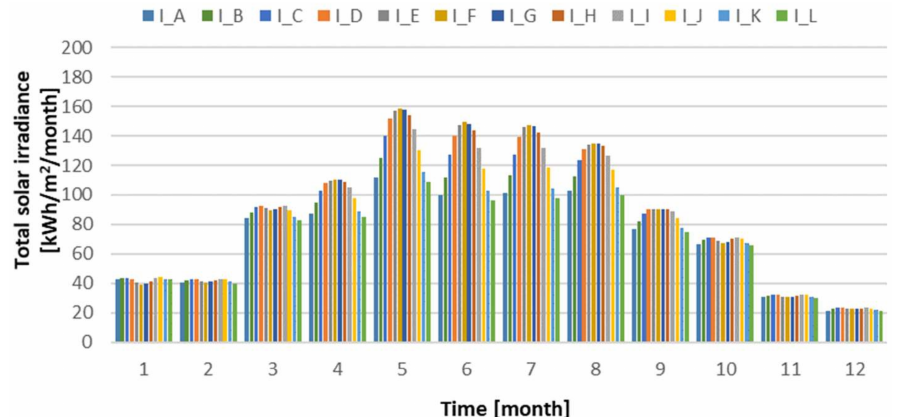
Figure 4. Total monthly solar irradiance incident on reference PV panels.